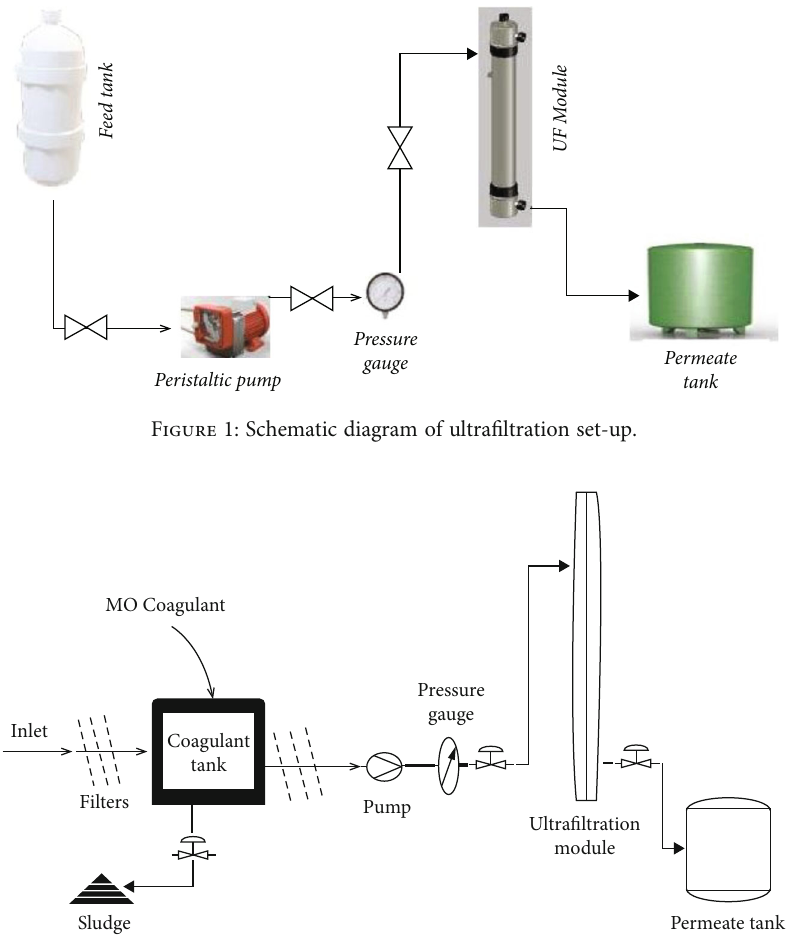
Figure 2: Flow chart of natural coagulation and ultra fi ltration-based wastewater treatment